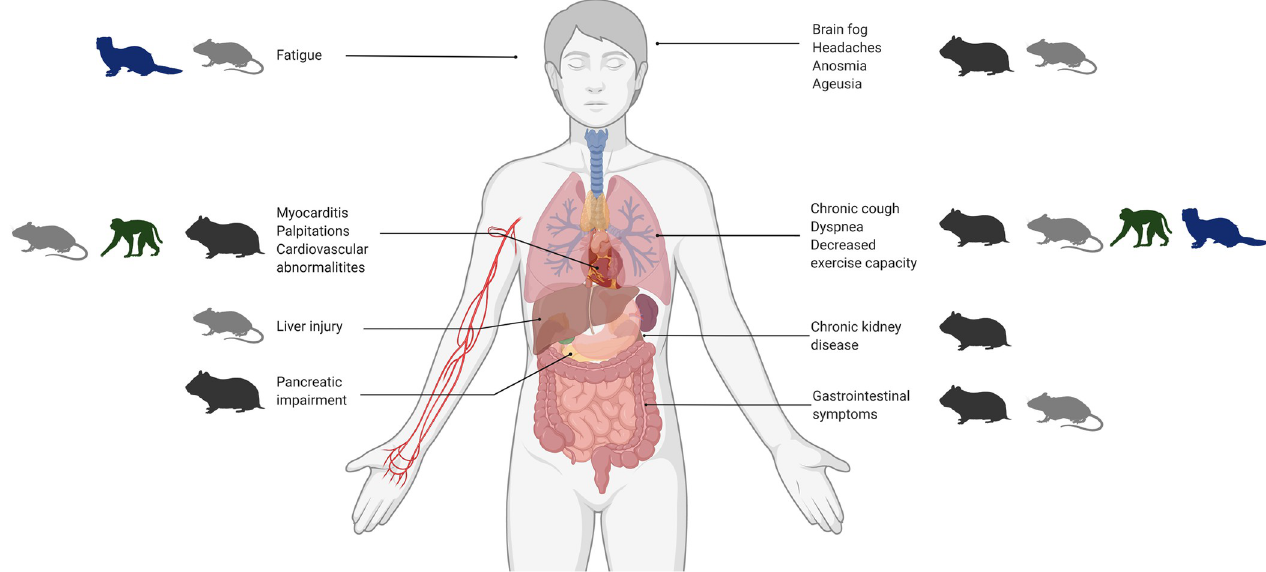
Fig 2. Potential animal models of post-acute sequelae of COVID-19 (PASC) manifestations. The 4 main groups of animal models (hamsters, mice, ferrets, and NHPs) are outlined with corresponding human manifestations of PASC. COVID-19, Coronavirus Disease 2019; NHP, nonhuman primate; PASC, Post- Acute Sequelae of